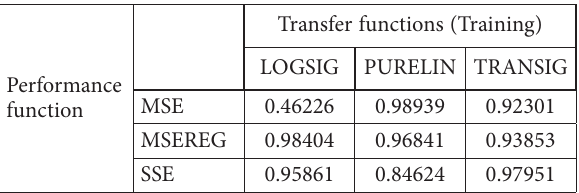
Table 3. Results for various Transfer functions for training R showing performance of system